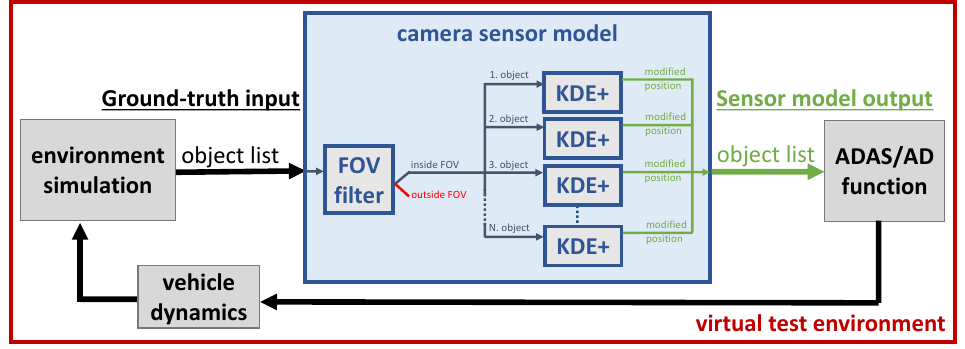
Figure 1. Camera sensor model at the object level embedded into a virtual test environment including environment simulation, ADAS/AD function, and vehicle